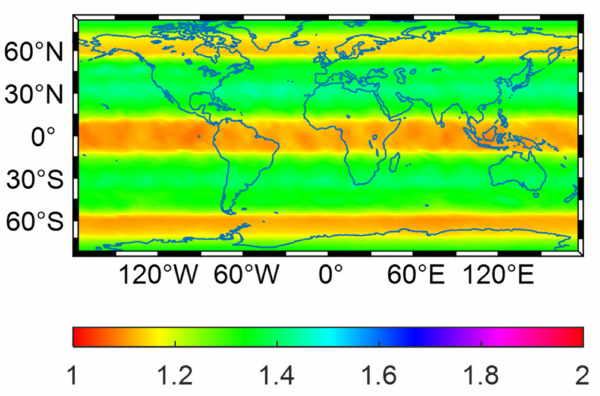
Figure 3. Average number of visible satellites for Galileo during DOY 248–254 of 2021.